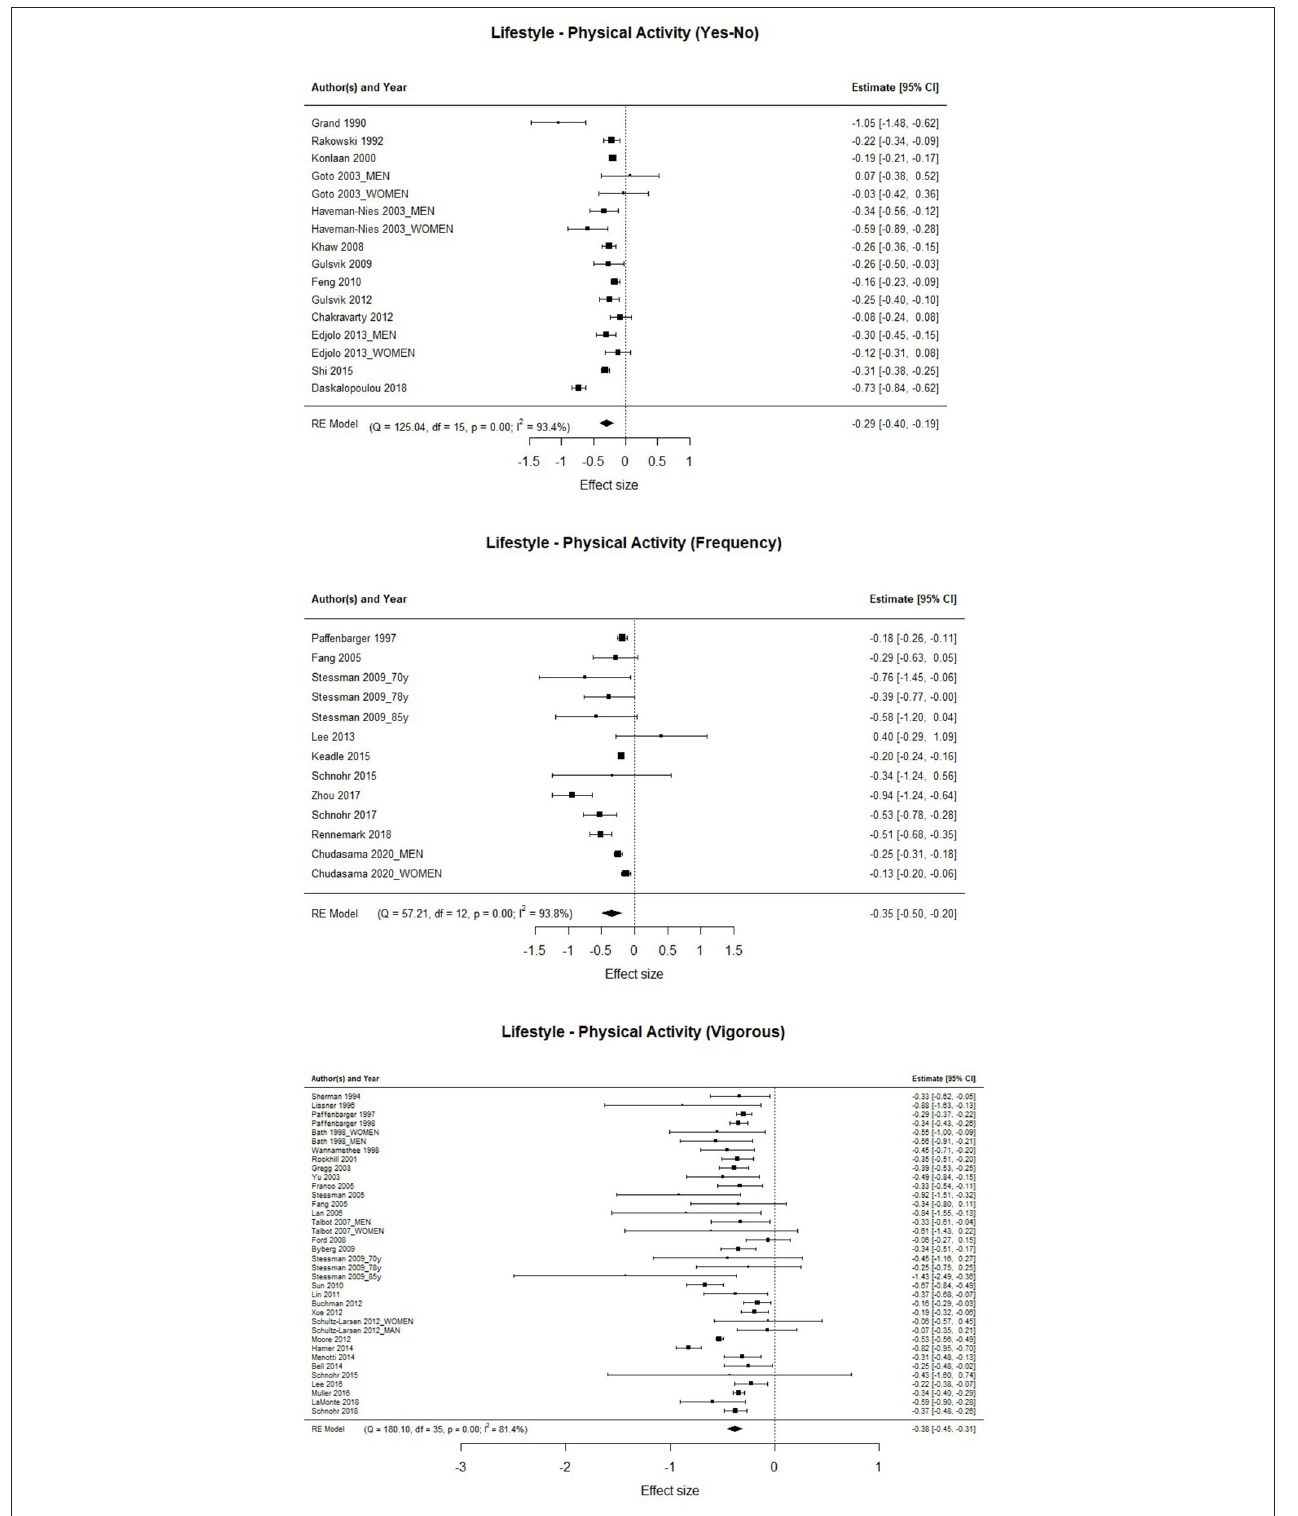
FIGURE 2 | Association between physical activity, frequency of physical activity, and vigorous physical activity, and the risk of mortality.